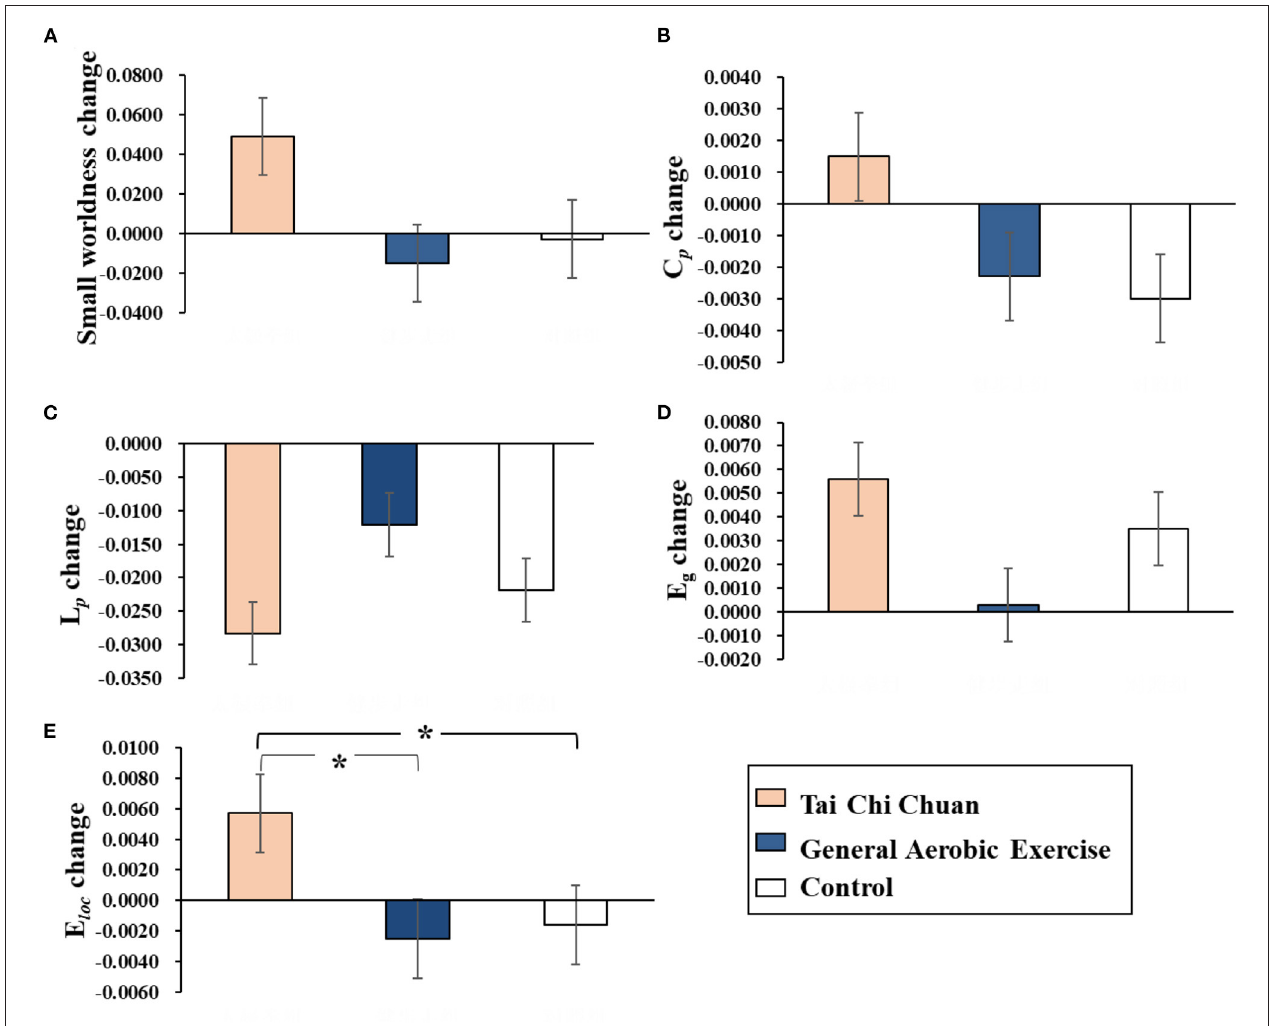
FIGURE 2 | Results of Bonferroni post-hoc statistical analysis of global network property changes (post minus pre). * p < 0.05. (A) Small-worldness. (B) C p . (C) L p . (D) E g . (E) E loc . C p , clustering coefficient; L p , characteristic path length; E g , global efficiency; E loc , local